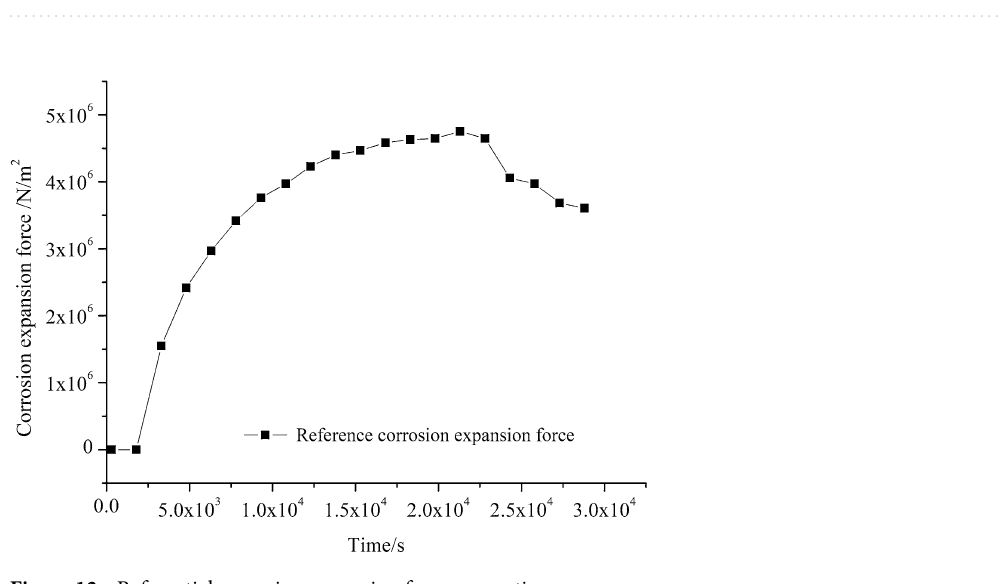
Figure 12. Referential corrosion expansion force versus